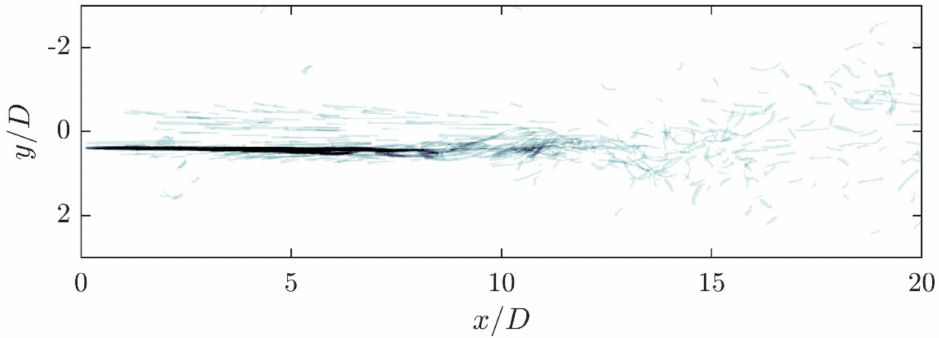
Figure 18. Superposition in the wake area of the orifice in the test facility scaled to scale 5 of the droplets injected away from the axis of symmetry, closer to the edge of the orifice (r ∗ = 0.75) in front of the orifice at Re =